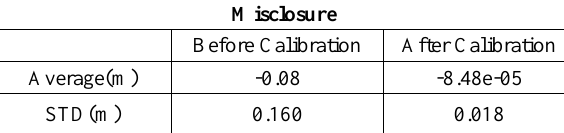
Figure 6. Main scenario of calibration filed